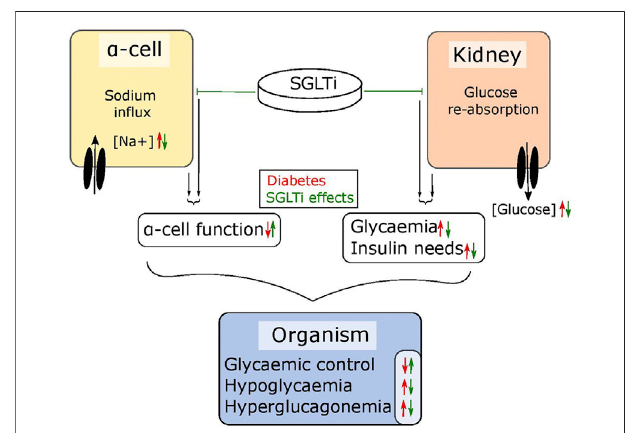
FIGURE 3 | SGLT inhibitors tackle diabetic symptoms from two angles. SGLTs maintain the sodium fl ux in alpha cells and glucose reabsorption in the kidneys. In diabetic individuals, the sodium in fl ux in alpha cells leads to dysfunctions in glucagon regulation while the reabsorption of glucose in the kidneys further elevates high blood glucose levels. SGLT inhibitors can – depending on their speci fi city – lower glycaemia by blocking reabsorption in the kidneys, which also lowers the need for required insulin and simultaneously restores alpha cell function. Together, this results in improved glycaemic